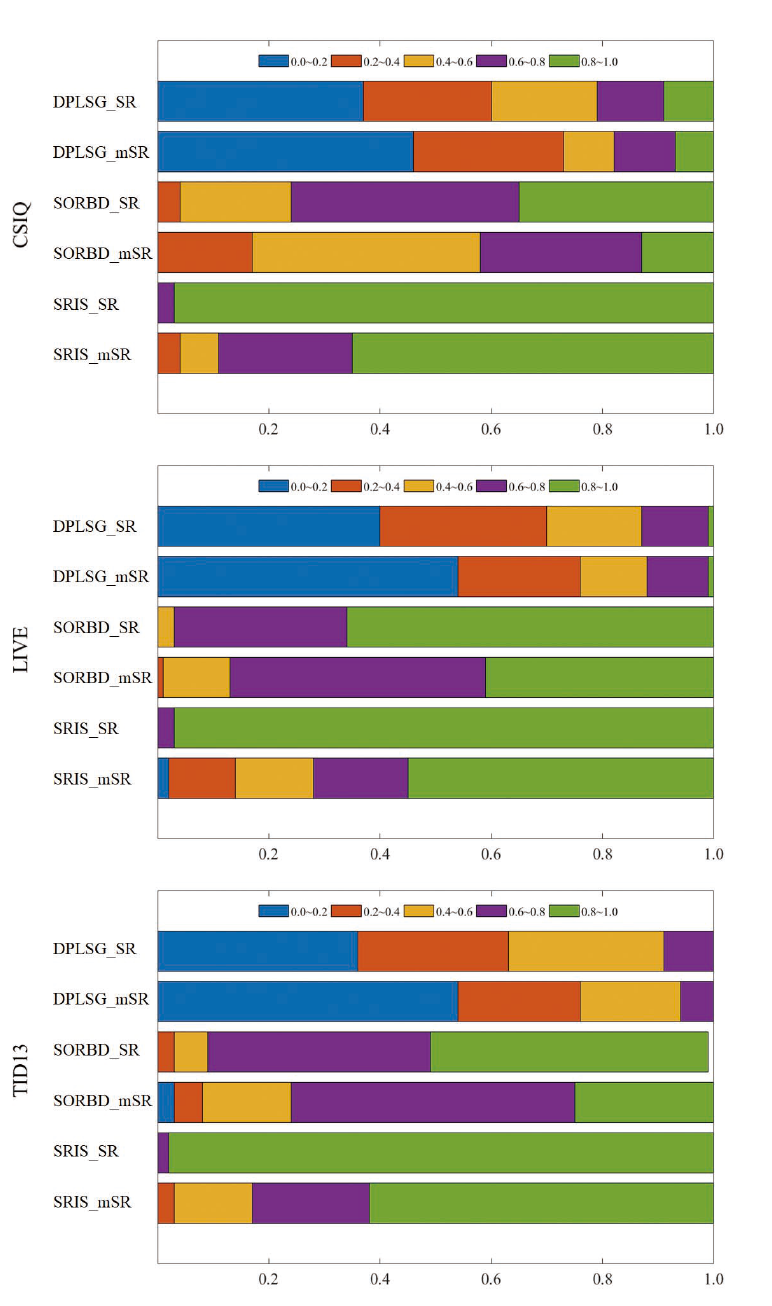
Figure 9. Distribution of the size proportion of used salient regions over the corresponding whole images. The size proportions are divived into five bins and denoted with different colors. (The figure can be enlarged for